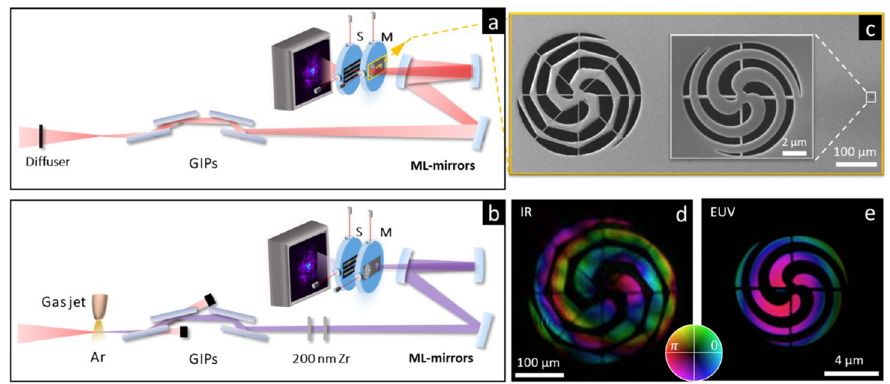
Fig. 1 Schematic setup of the position-correlated EUV/IR ptychographic microscope. a and b show the IR and EUV ptychographic setup. GIPs: grazing incident plates. ML mirrors: multilayer mirrors. M: mask. S: sample. c Scanning electron microscope (SEM) image of the amplitude-only masks which are used to structure the IR and EUV beam respectively. For the IR mask (left spiral in c ) a diameter of 300 μm was used and for the EUV mask (right in c ) a diameter of 10 μm was used. The inset in c shows an enlarged SEM image of the EUV mask for illustration. The distance between the two masks is 700 μm. d Reconstructed complex probe back-propagated to the mask plane in IR scan. e Reconstructed probe back-propagated to the mask plane in EUV